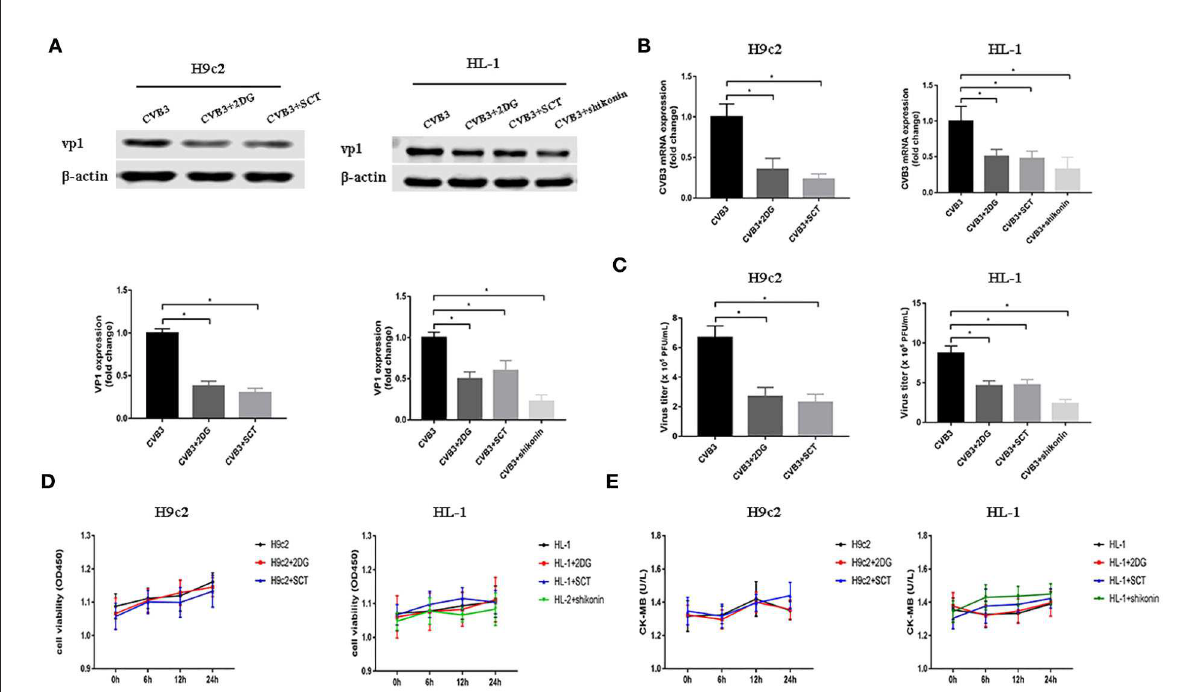
FIGURE2 Glycolysis inhibitors reduce CVB3 replication. H9c2 and HL-1 cells were infected with coxsackievirus B3 (CVB3) at a multiplicity of infection of 10, with or without glycolytic inhibitor treatment, and were harvested at 24h post-infection. Intracellular VP1 levels were measured by Western blotting (A) , and CVB3 RNA levels were measured by quantitative PCR (B) . Cell supernatant was harvested at 24h post-infection, and CVB3 viral titer levels were measured by plaque forming unit assay (C) . Myocardial cells treated with or without 2-deoxy-D-glucose, sodium citrate, or shikonin were detected at 0, 6, 12, and 24h by using the CCK-8 method (D) , and the culture supernatant creatine kinase MB levels were tested at the same time points (E) . Data are indicated as mean ± SEM; data represent three independent experiments with at least three technical replicates per experiment; * P <